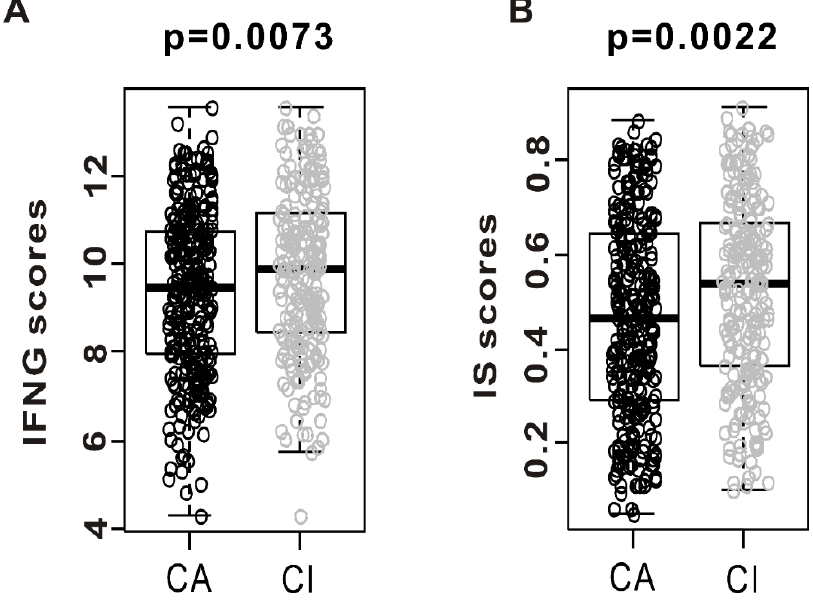
Figure 3. Evidence of immune activation in “CSMD1-activated” (CA) compared with “CSMD1-inactivated” (CI) subgroups. Gene expression level of interferon-gamma (IFNG) score and immune signature (IS) score were analyzed in both subgroups from the TCGA cohort. ( A ) Gene expression of interferon-gamma score was analyzed in CA and CI. ( B ) Immune signature score was also analyzed in both